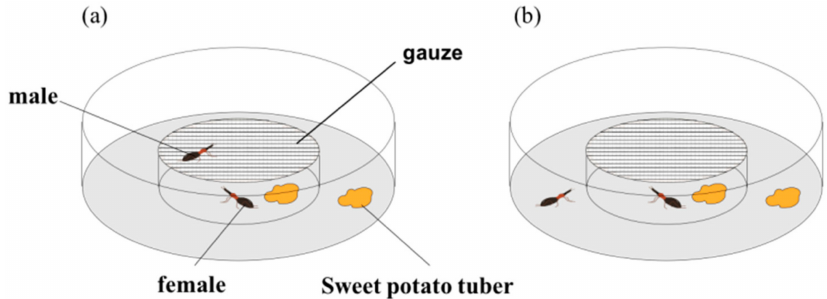
Figure 2. Arena of male searching for a mate: Phases of mate search of male of the SPW: Gauze was used to prevent interaction between male and female. ( a ) After the start of the experiment 30 min if males climb on gauze, it was defined as mate search. TI was measured for each male, ( b ) Orientation of male failed response to